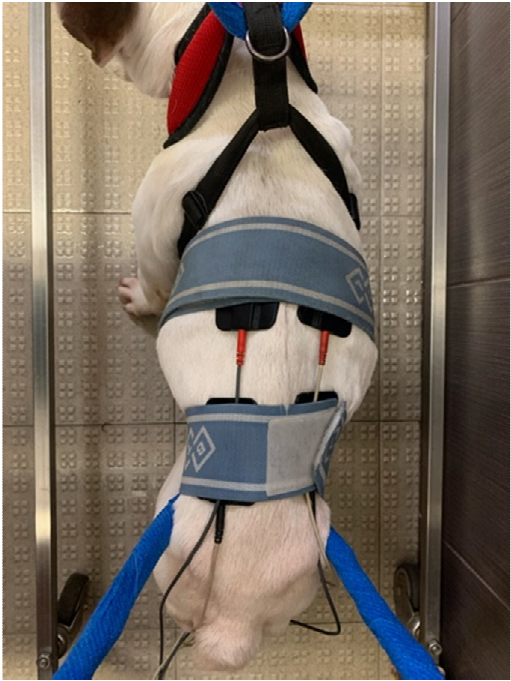
Figure 3. Interferential electrical stimulation. Four electrodes crossed at a 90° angle near the spinal hyperesthesia region.